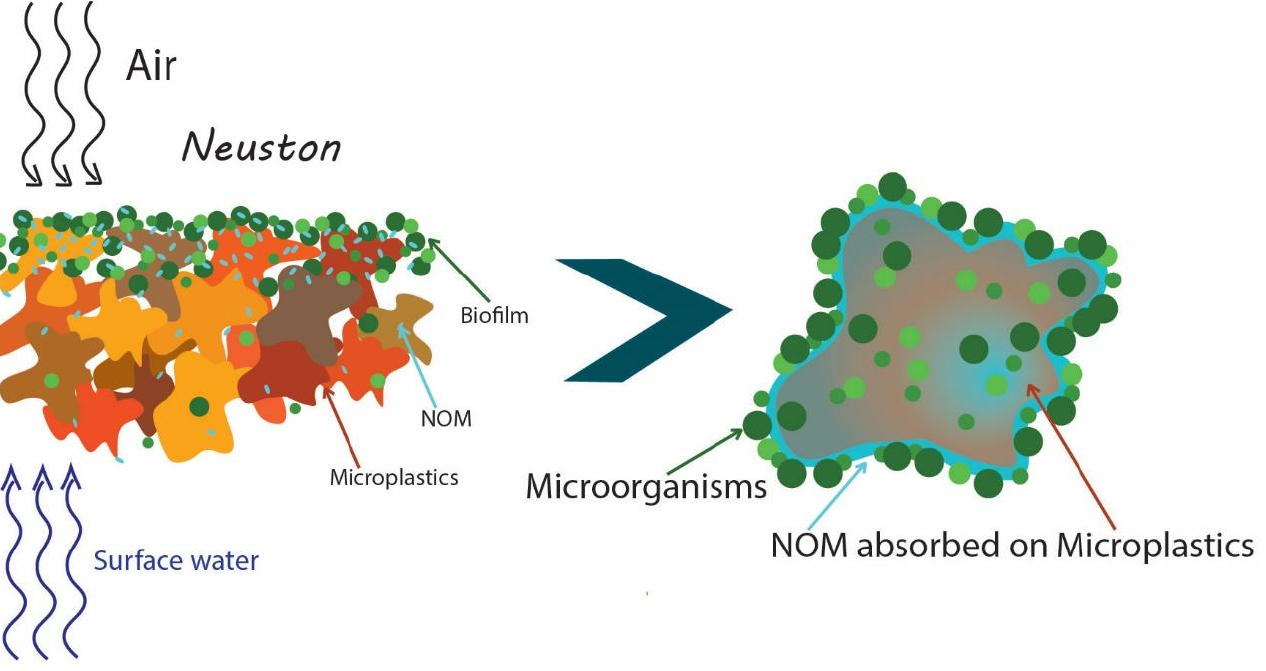
Figure 1. Concept of interaction between microplastic particles, bacterioneuston, considering its location in water column and natural organic